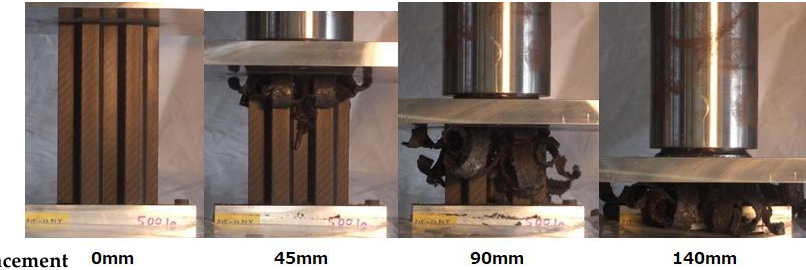
Figure 13. Progressive crushing procedures of compression test (case: 12ply-P15).